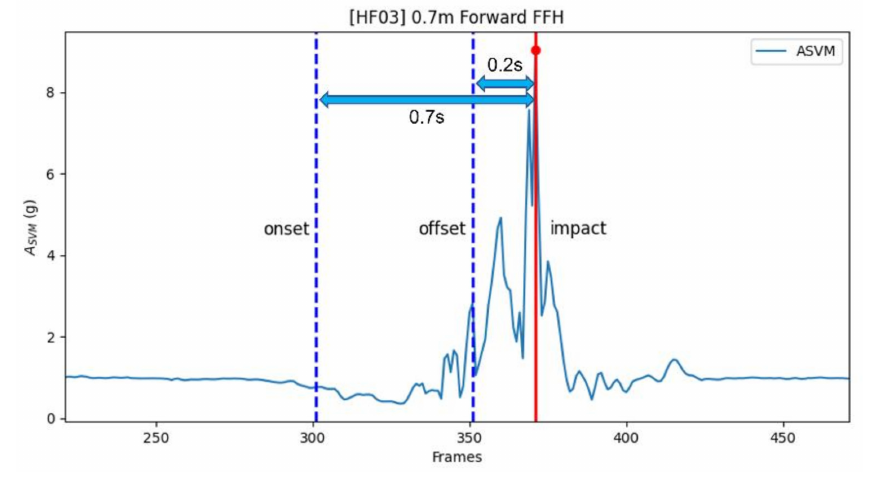
Figure 1. An example of the window